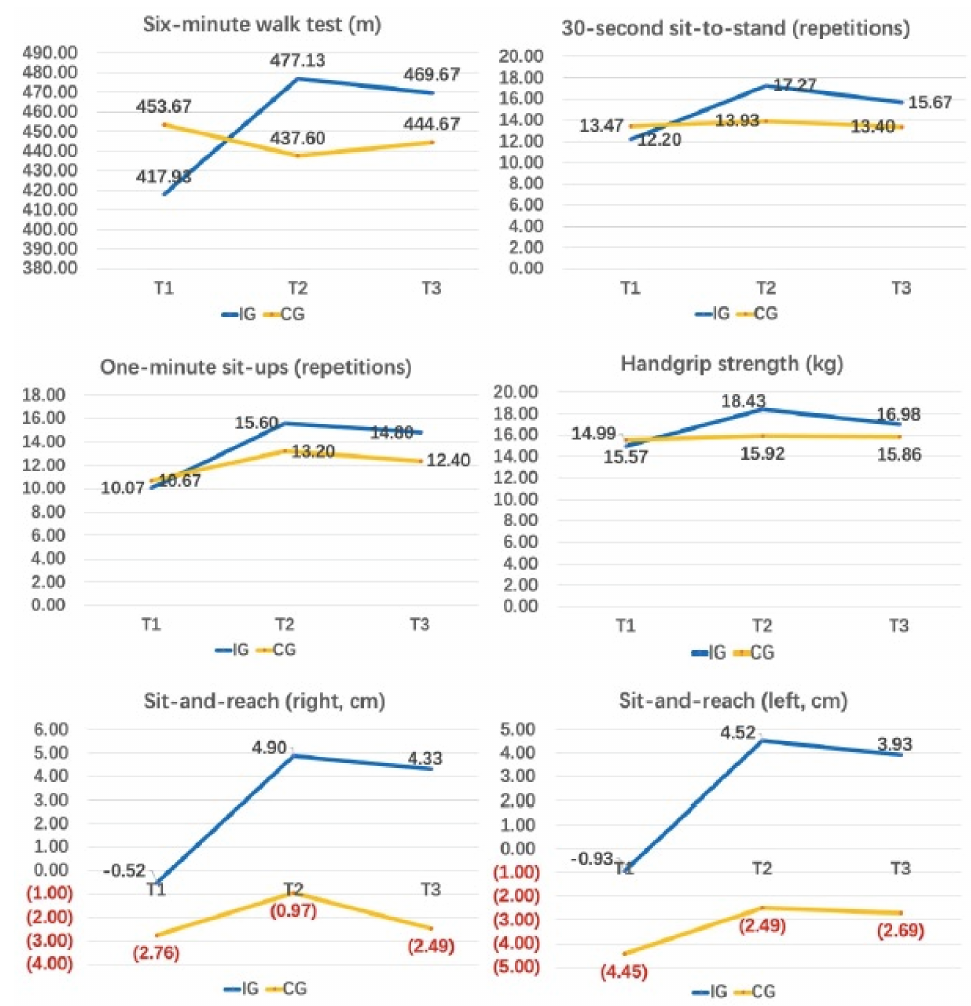
Figure 3. Changes in HRPF-related outcomes across the three-time points.